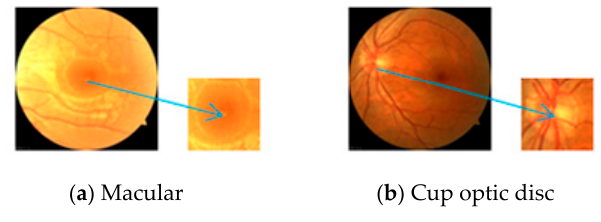
Figure 6. Preprocessing of concentrated data.